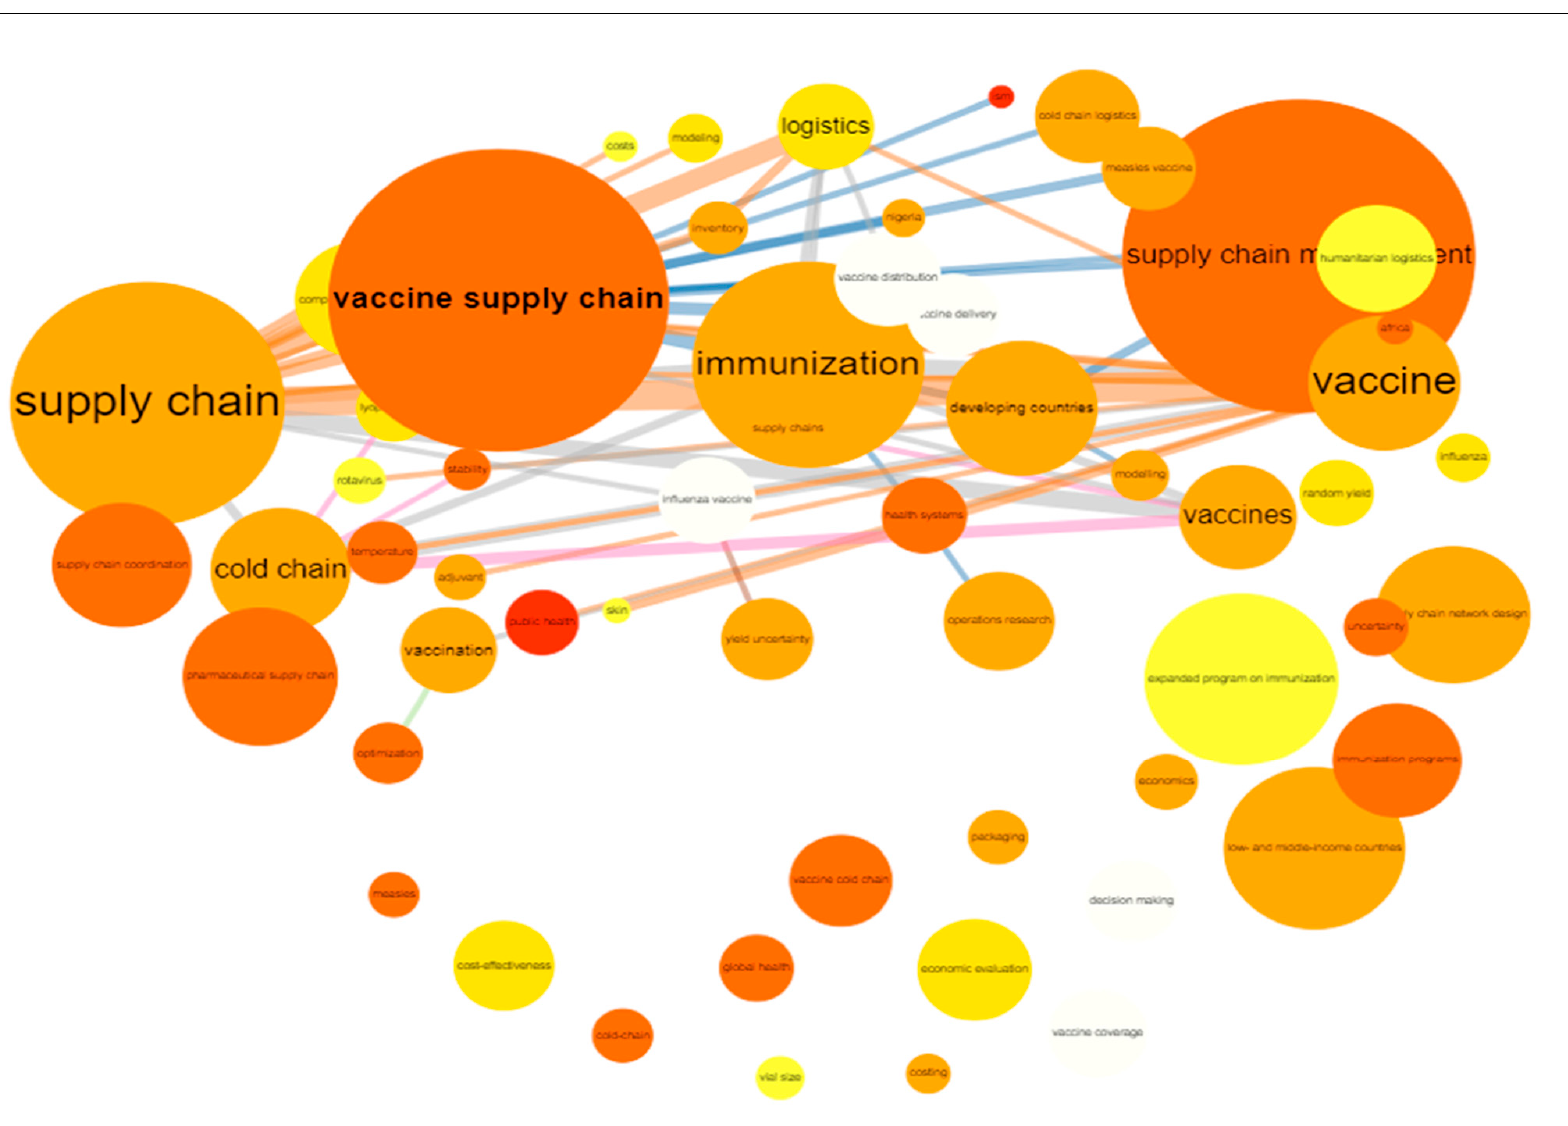
Figure 10. Disciplines involved in VSCM.